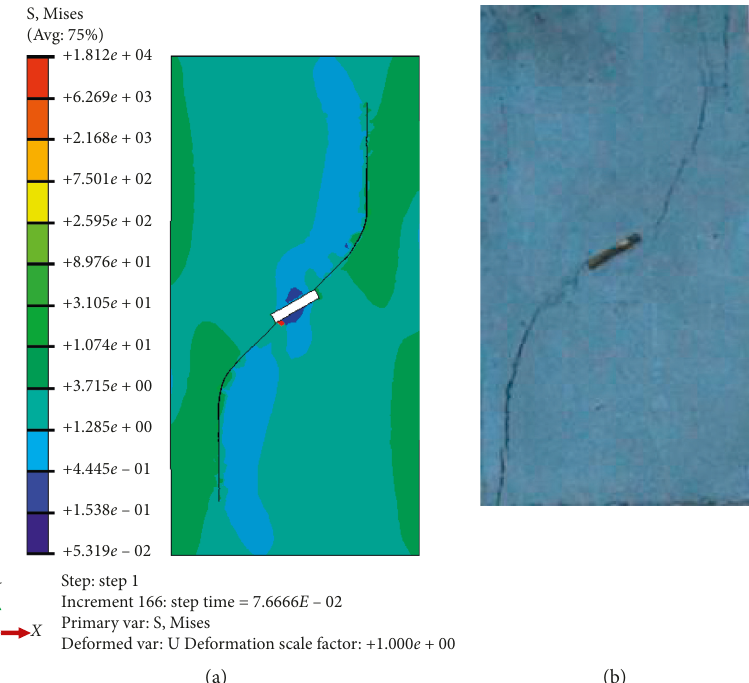
Figure 9: Numerical and experimental results of fracture propagation with 2 mm thick crack and β � 75 ° : (a) numerical analysis; (b) experimental results.